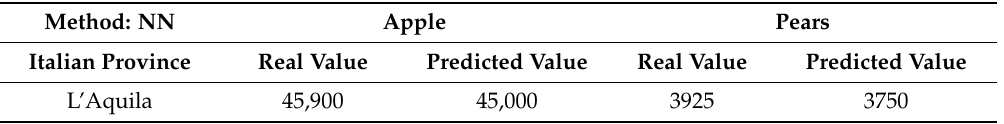
Table 5. Task 1: a comparison example between the real values and their neural network model prediction for the apple and pear total crops for the Italian province of L’Aquila on the Istat dataset. Method: NN